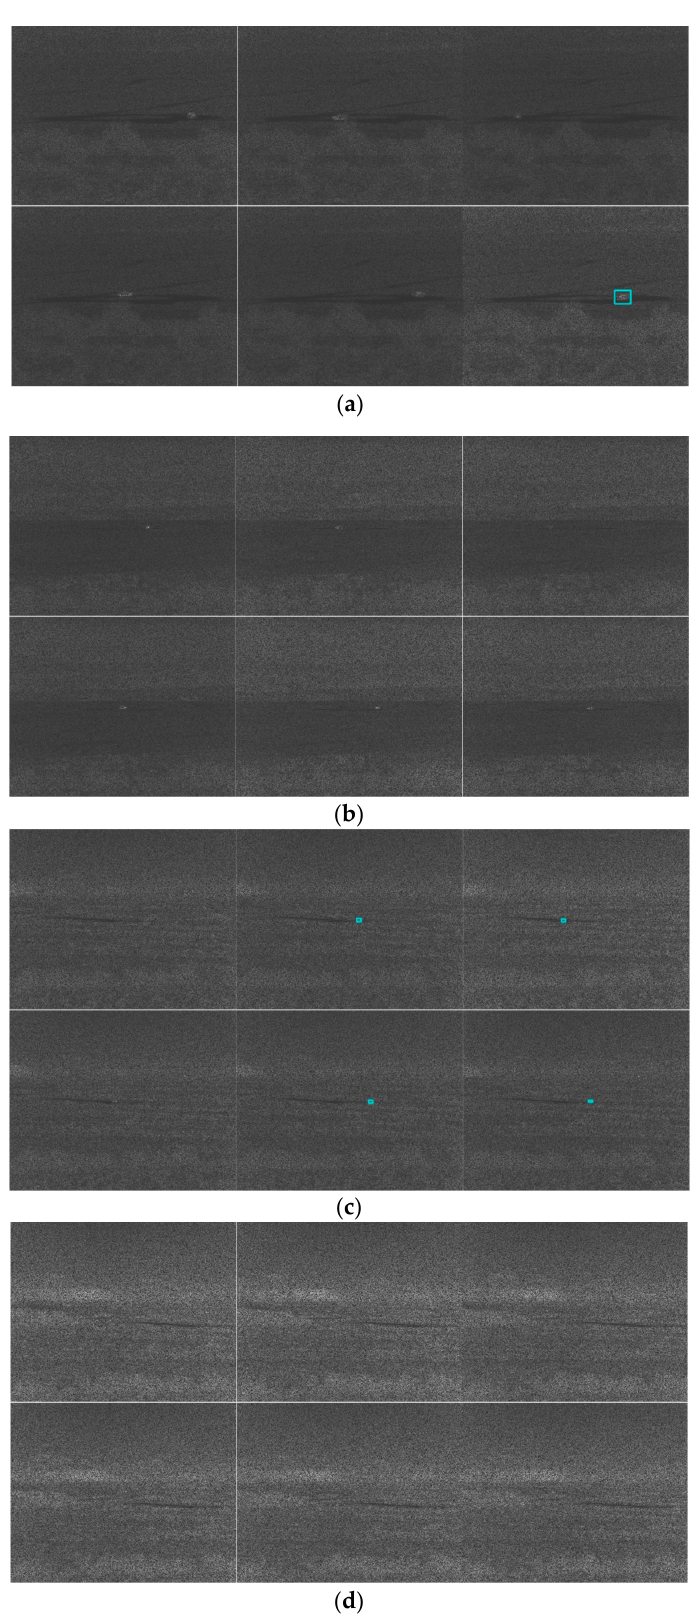
Figure A5. Tracking results for frames 1, 60, 119, 178, 237, and 296 for the PCE 50 (MWIR nighttime) case. The vehicle is SUV. ( a ) 1000 m; ( b ) 2000 m; ( c ) 2500 m; and ( d ) 3500 m. Table A10. Tracking metrics for PCE 25 (MWIR nighttime). ND means no detection.